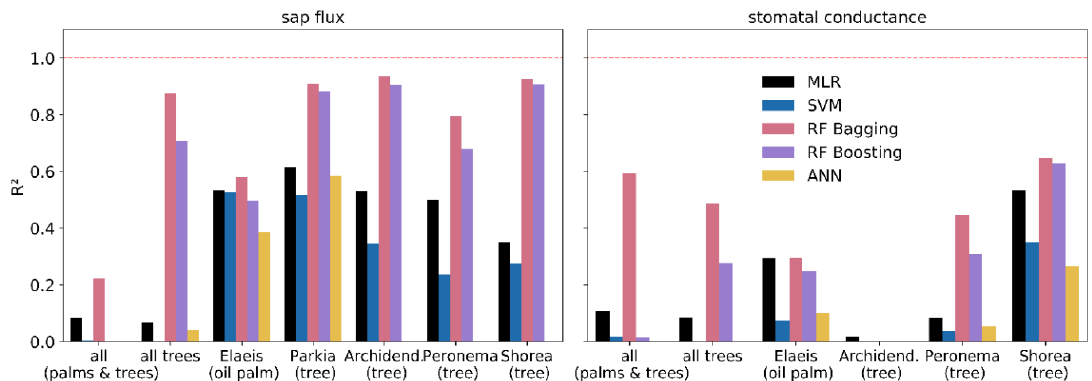
Figure 5. Coe ffi cient of determination (R 2 ) for predicted and measured values for sap flux and Figure 5. Coefficient of determination (R²) for predicted and measured values for sap flux and stomatal conductance. stomatal conductance.